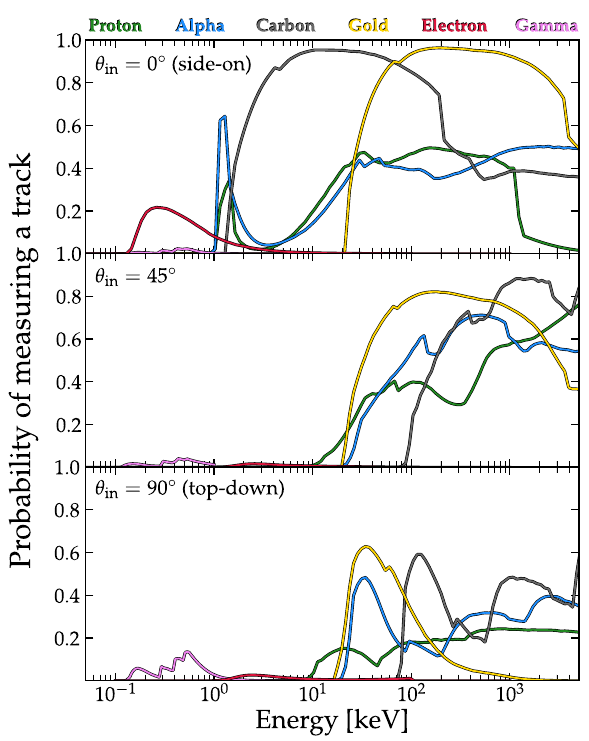
Fig. 6 Probability of measuring a track for θ in = 0 ◦ (top), θ in = 45 ◦ (middle) and θ in = 90 ◦ (bottom) beam angles as a function of primary beam energy. Colours correspond to different primary particle types, as indicated. A measurable track is defined to be one consisting of 3 or more events, each depositing more than 10 eV in a single DNA component volume